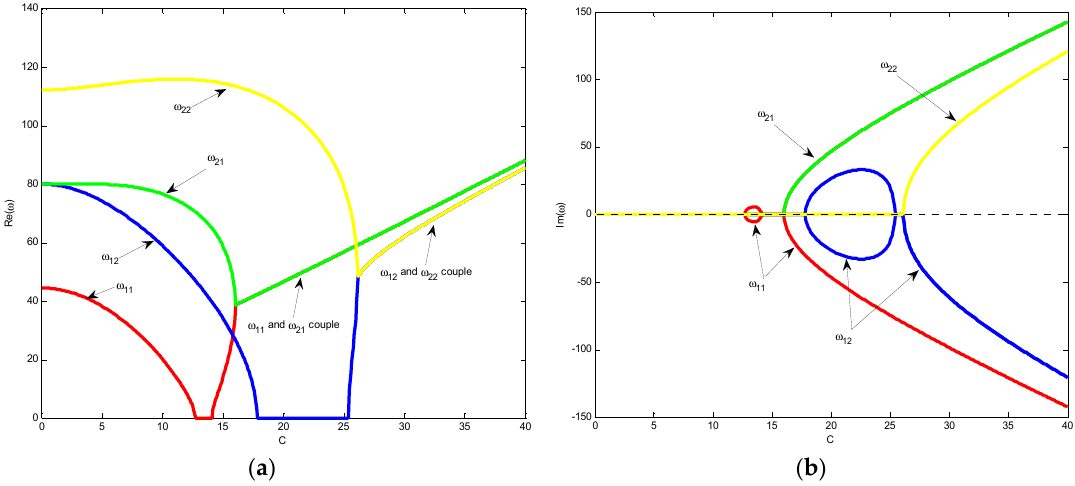
Figure 3. Dimensionless complex frequencies vs axially moving speed for the nanoplate without a foundation. Appl. Sci. 2019 , 9 , x FOR PEER REVIEW